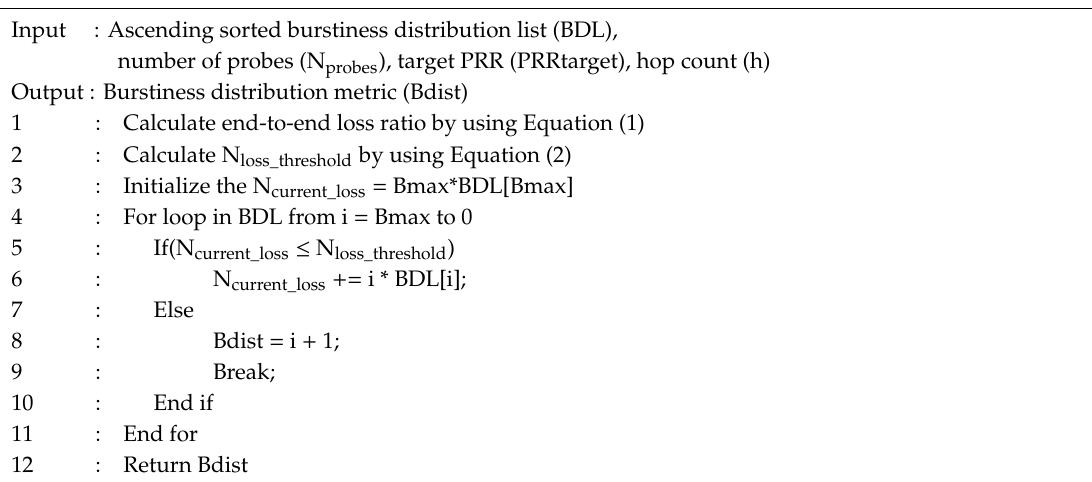
Algorithm 2: Calculate Burstiness Distribution